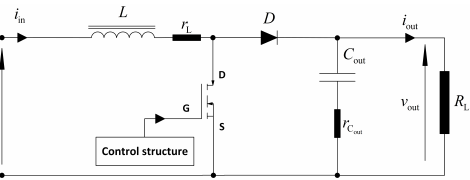
Figure 1. Equivalent circuit diagram of a boost converter considered as a plant under control for purpose of mathematical derivation of control − to − output transfer function, P mat,c,c2o inductor L equivalent series resistance r L and output capacitor C out equivalent series resistance r C been taken into